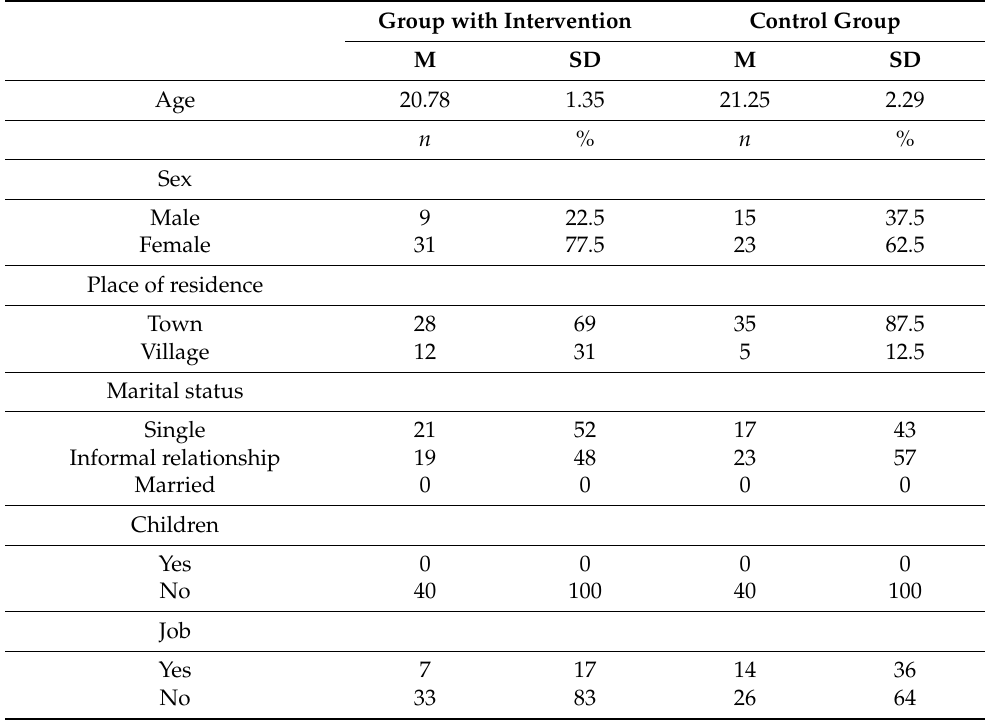
Table 1. Characteristics of the sample ( n =